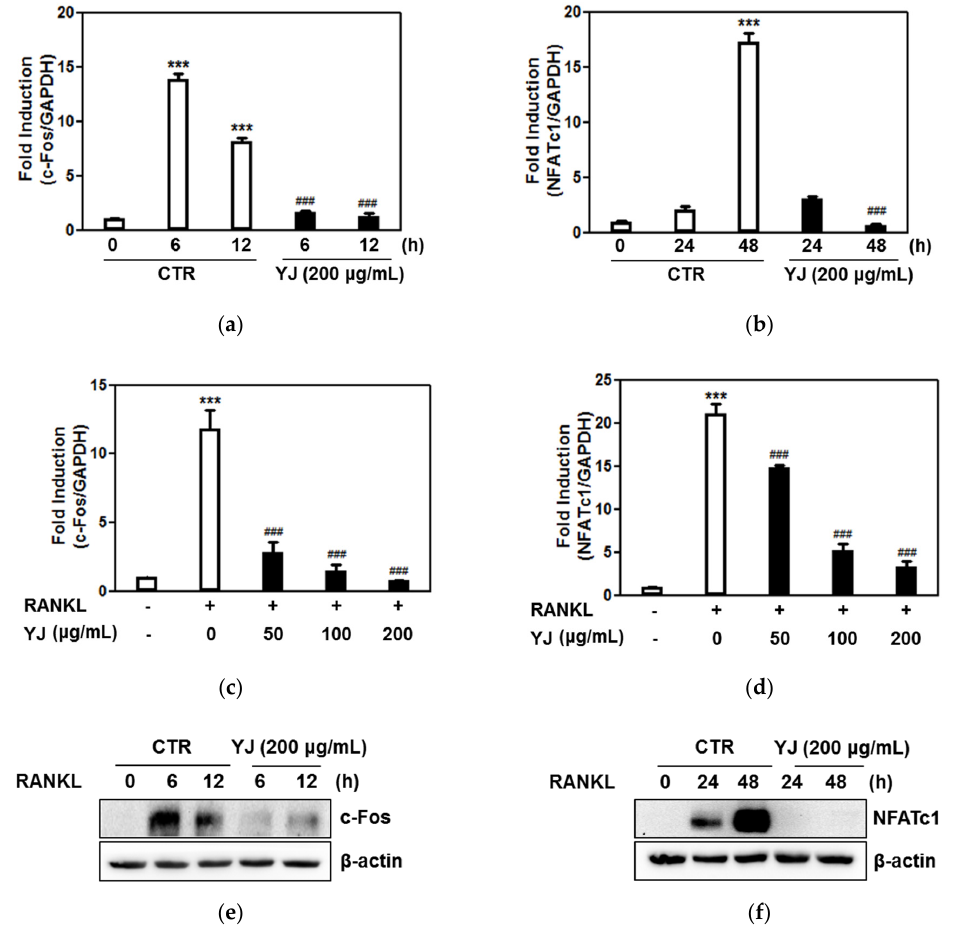
Figure 5. YJ suppressed RANKL-mediated expression of c-Fos and NFATc1 in BMMs. BMMs were treated with M-CSF and RANKL in the presence or absence of YJ (200 μ g/mL) for the indicated time. ( a – d ) Total RNA was isolated from cells and mRNA expression levels of c-Fos and NFATc1 were measured by quantitative real-time RT-PCR. ( e , f ) The cell lysates were subjected to Western blot analysis with c-Fos and NFATc1 antibodies. β -actin was used as a loading control. The data are presented as the mean ± SD of three independent experiments. *** p < 0.001 vs. the control group and ### p < 0.001 vs. the RANKL-treated group at indicated times and concentrations.